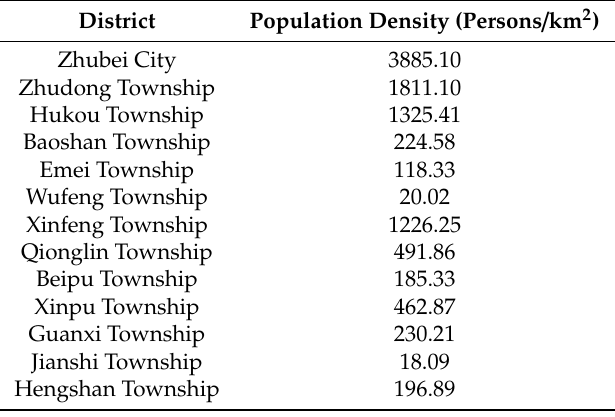
Table 5. Population density of each township in Hsinchu County in